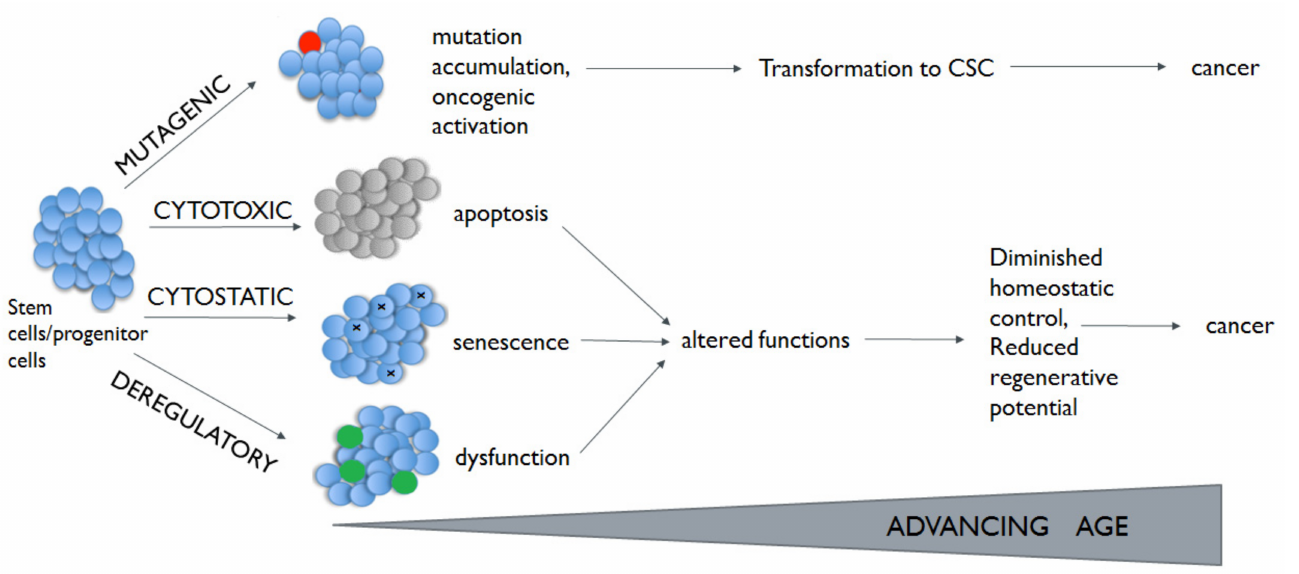
Figure 1. Age-related DNA damage in stem cells. Mutation accumulation and/or oncogenic activation leads to transforma- tion to cancer stem cells (CSCs; marked red) and the initiation of cancer. Cytotoxic and cytostatic effects lead to stem cell senescence or apoptosis. It may result in reduction in the stem cell population. Deregulatory mechanisms lead to reduced homeostatic control and diminished regenerative potential.